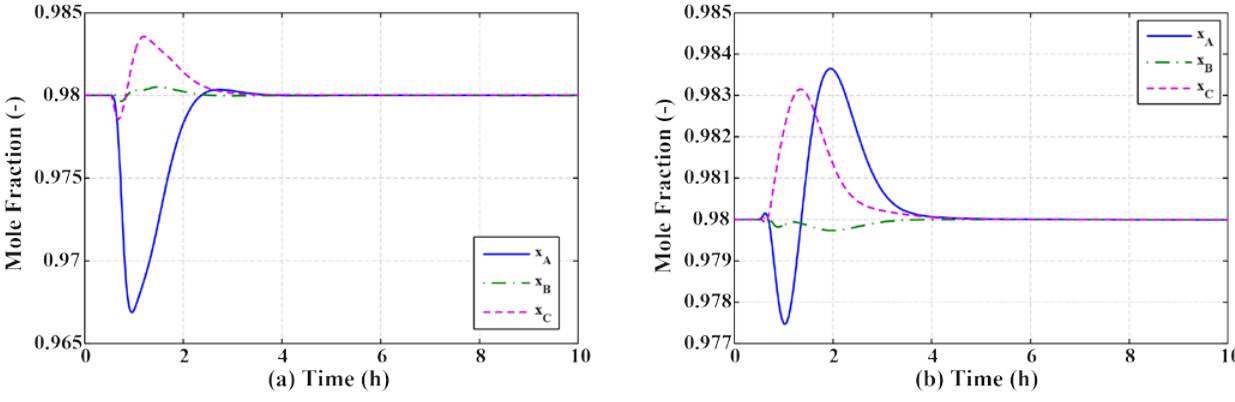
in the feed 𝑥 𝐴